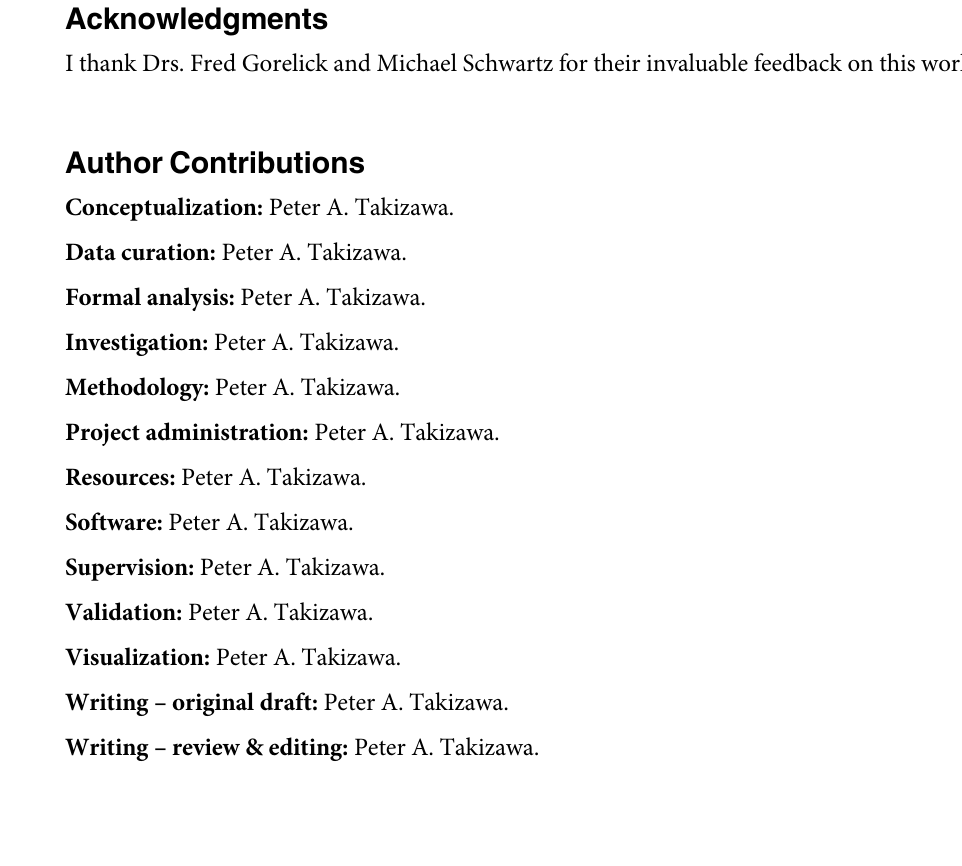
S1 Fig. Evaluation of topic models by topic coherence and perplexity. LDA Mallet was used to generate topic models for texts from the class of 2024. Models were generated for topic numbers from 10 to 150 at increments of 10. The quality of the model at each topic number was evaluated by topic coherence and perplexity on a held-out set of texts. Models with higher topic coherence scores have been found to generate topics that make more sense to human reviewers. Models with lower perplexity scores more accurately predict words in an unseen set of texts. S2 Fig. Yale school of medicine competencies. A list of nine competencies that students are expected to meet before graduating. A major goal is to map content in the curriculum to these competencies. S3 Fig. Human mapping of course objectives to competencies has similar distribution as mapping of content done by topic model. The mapping of content to competency is the same as in Fig 2. Superimposed is the mapping of course objectives to competencies performed by the course directors. Each course director mapped the objectives for their course to the competencies. The results show the mapping combined from all the courses in the pre-clerk- ship